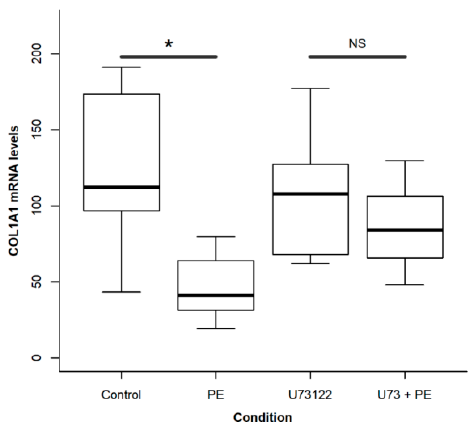
Figure 8. Influence of U73122 on phosphatidylethanolamine (PE)-induced collagen expression. Cells grown in six well plates were incubated for 48 h in serum-free culture medium with PE 50 µg mL − 1 , either in the presence or absence of U73122 10 µM in dimethyl sulfoxide (DMSO). Controls were incubated with the same amount of DMSO used in the experimental wells. Individual comparisons were made for each pair of control and experimental groups with Student t test. Asterisk indicates a p < 0.05, NS: